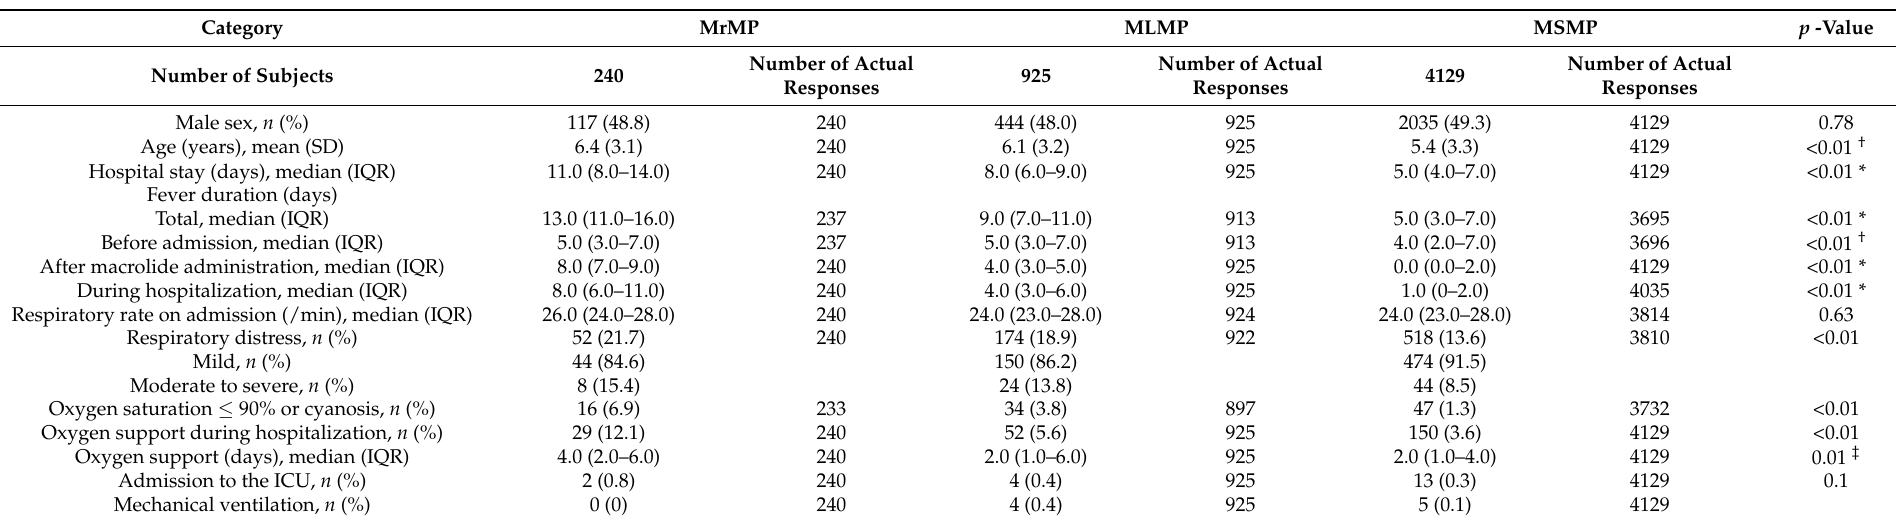
Table 2. Comparison of clinical characteristic in Mycoplasma pneumoniae pneumonia patients.